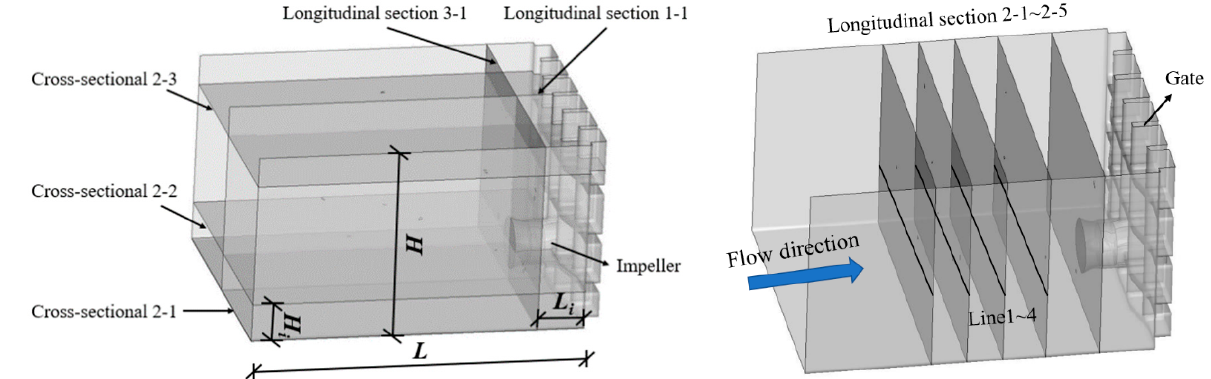
Figure 7. Schematic diagram of the selection of feature sections and axis positions.